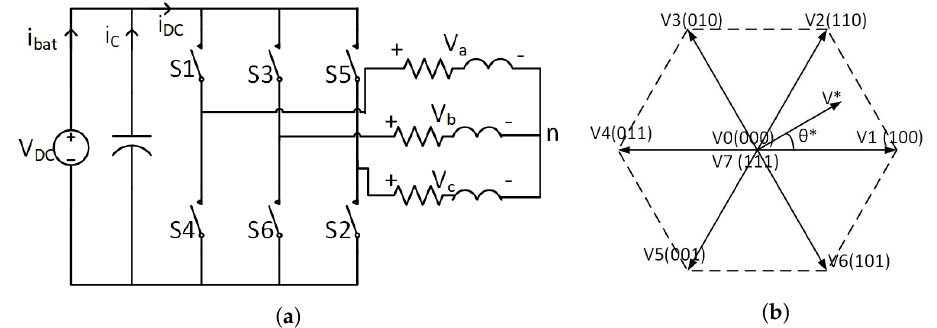
Figure 2. Three-phase two-level inverter ( a ). Original representation ( b ). Corresponding space vector formulation in stationary d-q